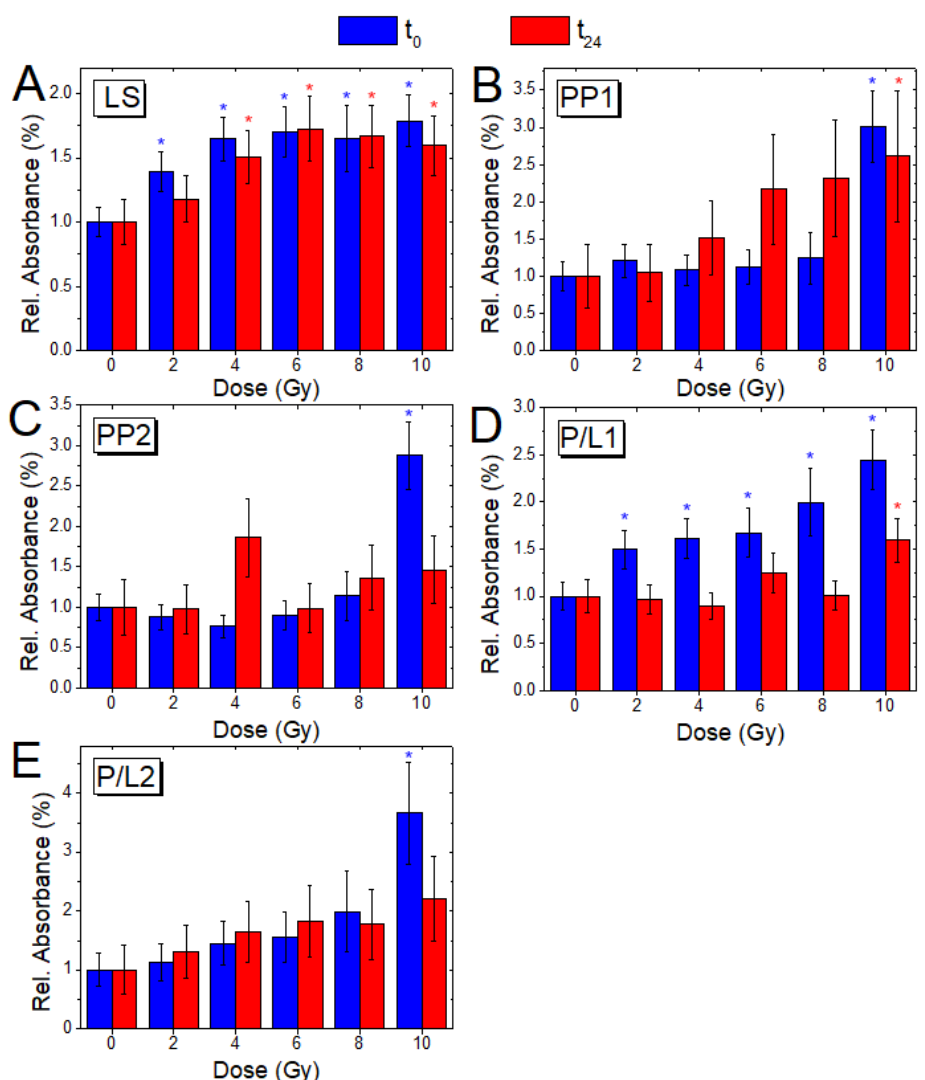
Figure 6. Comparison of the absorbance ratios LS ( A ), PP1 ( B ), PP2 ( C ), PL1 ( D ) and PL2( E ) with dose, for cells fixed immediately ( blue ) and 24 h after irradiation ( red ); the ratio variations (Mean ± SD) are reported, as a value normalized with respect to the corresponding ratio value of the non-irradiated samples (0 Gy, t 0 ; 0 Gy, t 24 ); blue and red asterisks indicate when a significant difference in respect to the control value for the t 0 and t 24 samples, respectively, occurred at 𝑝 ≤ 0.05 .